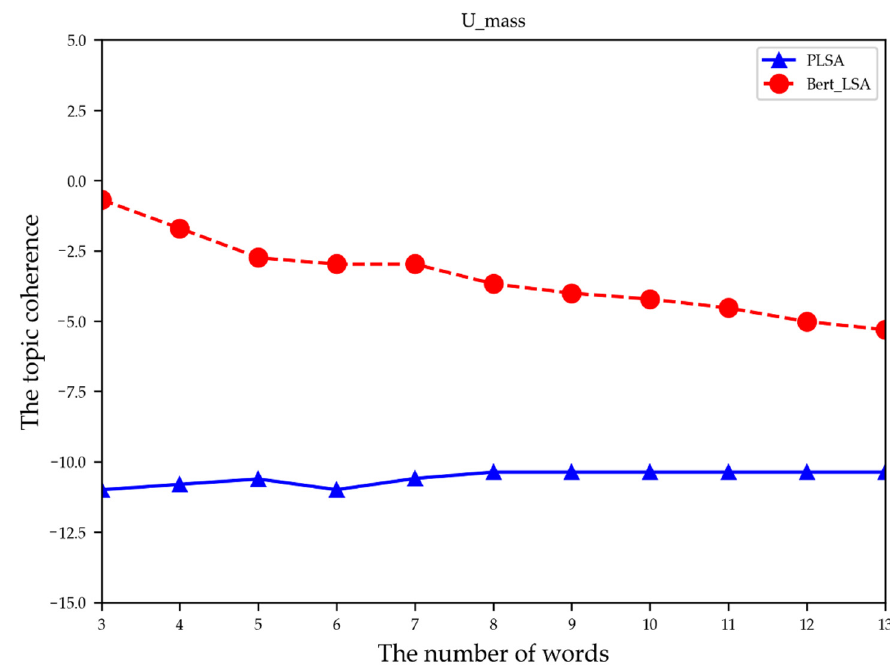
Figure 6. Topic consistency values of PLSA and Bert-LSA models obtained by the U-Mass method.